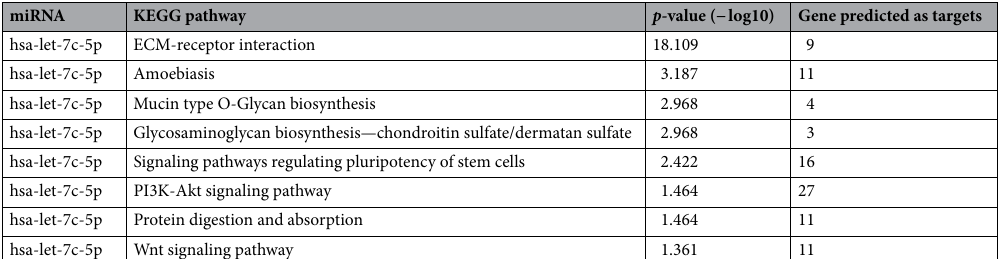
Table 4. Significant KEGG pathways potentially influenced by up-regulated let-7c-5p in the aqueous humor of normal tension glaucoma patients. KEGG Kyoto encyclopedia of genes and genomes, ECM extracellular matrix.